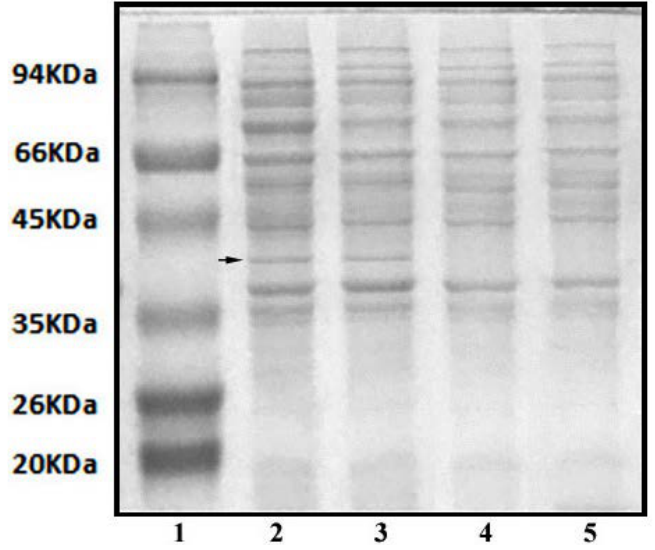
Figure 8. SDS-PAGE analysis of extracellular proteins. Lane 1 : middle mw protein marker; Lane 2 – 5 : extract of extracellular proteins from bacteria incubated in polymer medium for 36 h, 24 h, 12 h and 0